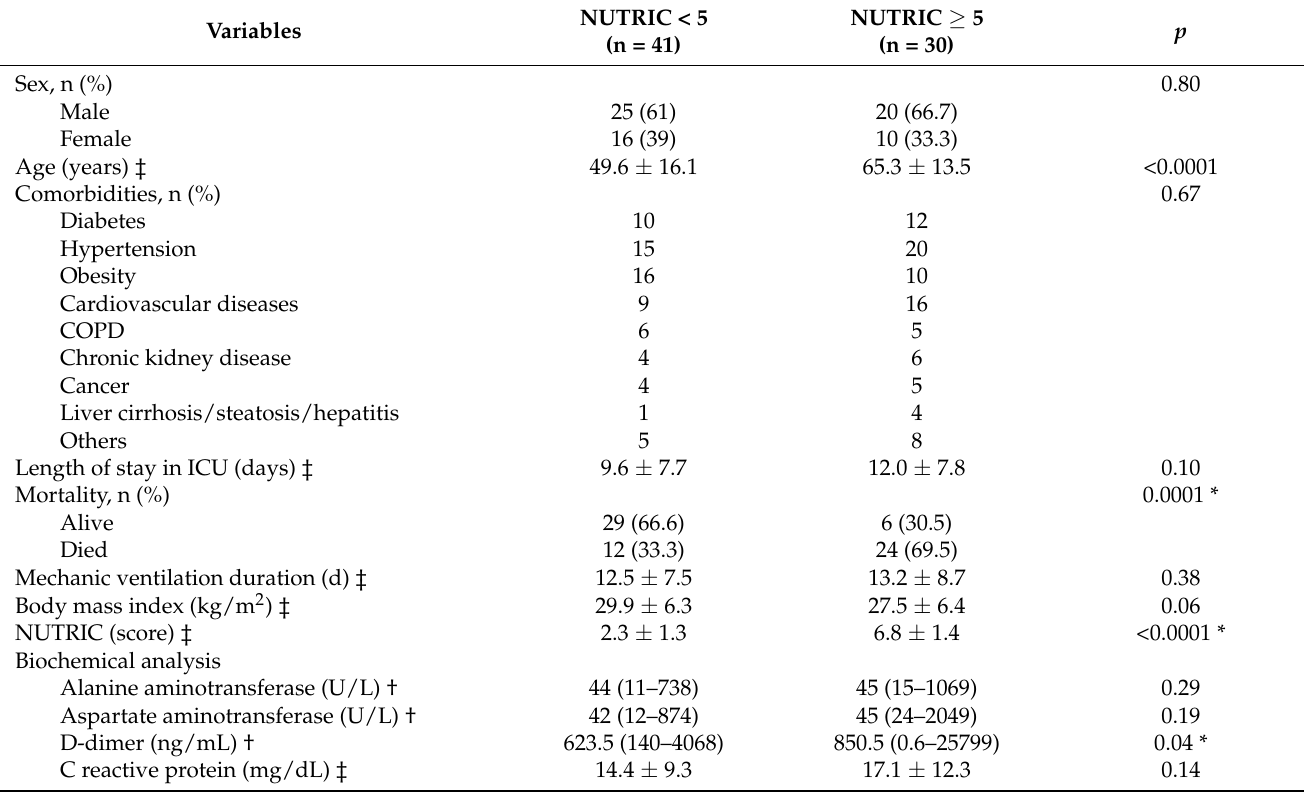
Table 1. Socioeconomic and clinical variables of patients with suspected COVID-19 admitted to the ICU according to NUTRIC